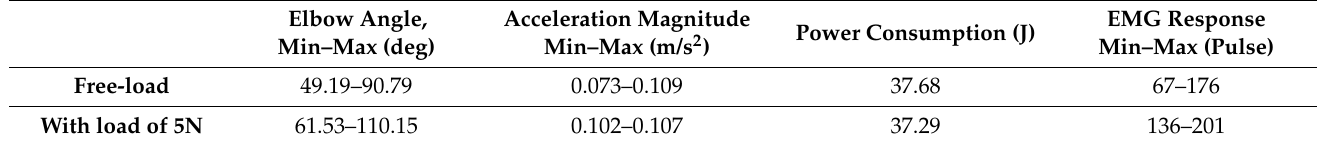
Figure 7. Results of a free-load assisted motion: ( a ) Acquired elbow articulation angle; ( b ) Acquired acceleration of wrist; ( c ) Acquired power consumption (from drawn motor current); ( d ) Acquired EMG sensor signal. Table 3. Experimental test